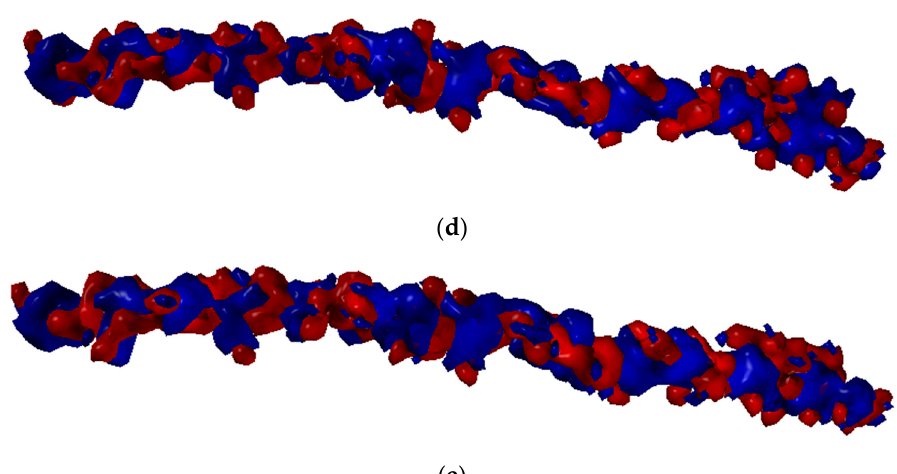
Figure 6. Electrostatic potential maps determined for selected structures of Collagen ( a ) and chitosan DD = 25% ( b ), DD = 50% ( c ), DD = 75% ( d ), and DD = 100% ( e ). Blue color stands for the positive charge, white red color denotes negative charge.